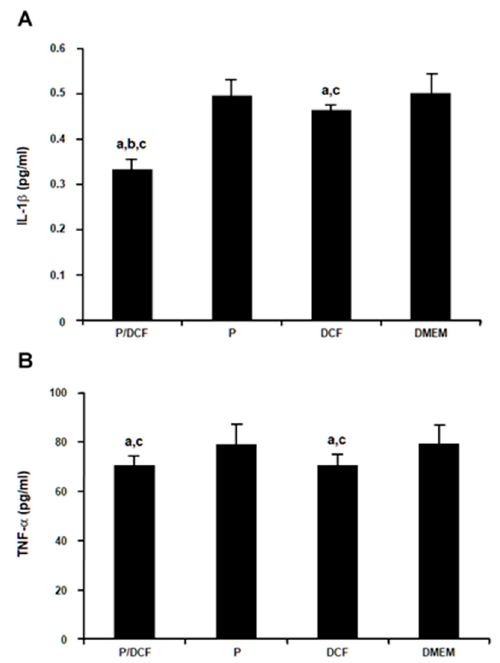
Figure 8. Analysis of inflammatory responses in hMSCs treated with PolyCD-based nanoassemblies (2 mg/mL). hMSCs (2 × 10 4 cells/well in 24-well plates) were directly incubated with the compounds. Inflammatory responses ( A : IL-1 β ; B : TNF α ) were detected using IL-1 β and TNF- α ELISAs, respectively, after 48 h as described in the Materials and Methods. Statistically significant compared with DMEM (a), DCF (b), and P (c). Abbreviations: P/DCF: PolyCD@Ada-Rhod/DCF; P: